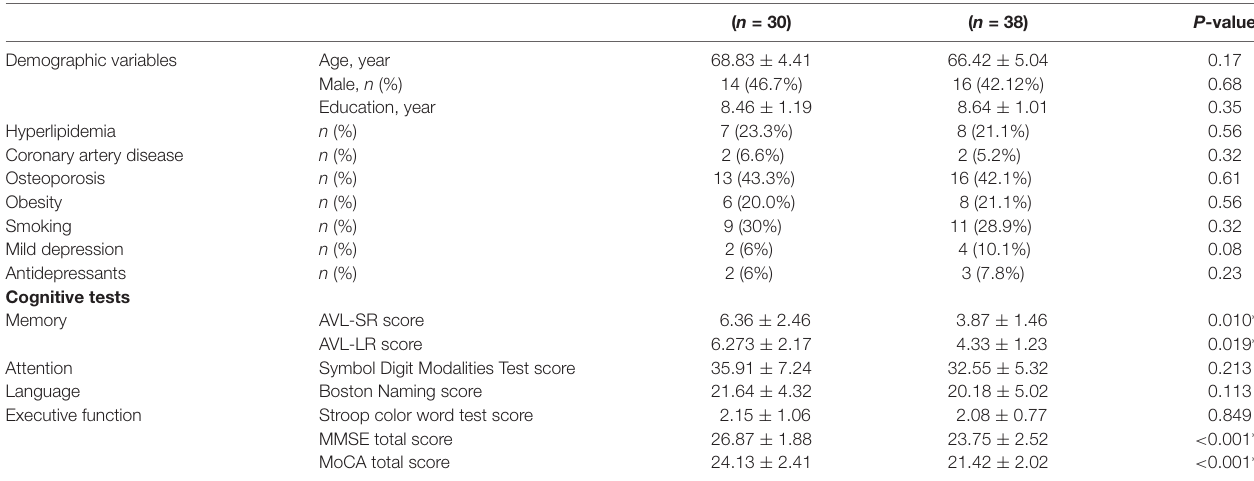
TABLE 1 | Group differences in demographic and clinical